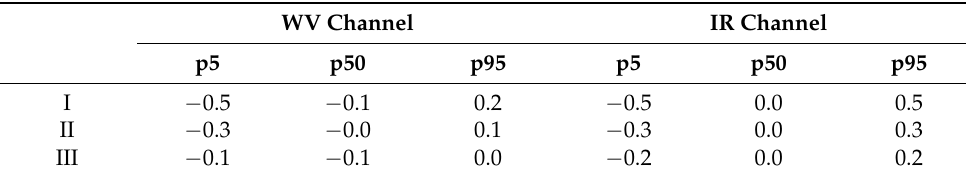
Table 1. Percentile values of the histogram analysis for the three different model settings to train the WV and IR model shown in Figure 8. I, II and III represent the cases for different model settings as described in Figure 8. p5, p50 and p95 represent the 5th, 50th, and 95th percentile of data distribution in the histogram analysis for each case. The values are mean BT shift (K) between the original and synthesized MFG channels.